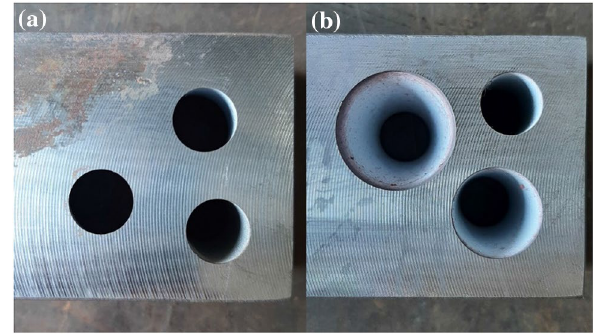
Fig. 5 a Top and b Bottom view of a test manufactured